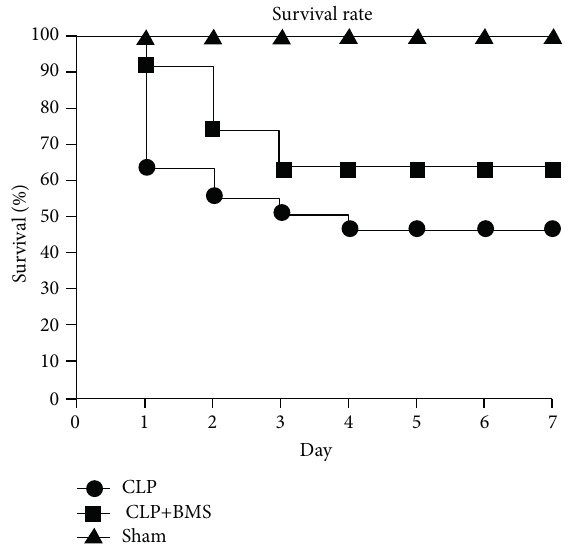
Figure 7: NF- 𝜅 B inhibition after CLP does not alter survival. Kaplan-Meier curves were plotted for mice subjected to CLP (+vehicle),CLP+BMS,orshamlaparotomy( 𝑛 = 25 pergroup).Log- rank test comparing CLP+vehicle and CLP+BMS: 𝑃 = 0.144